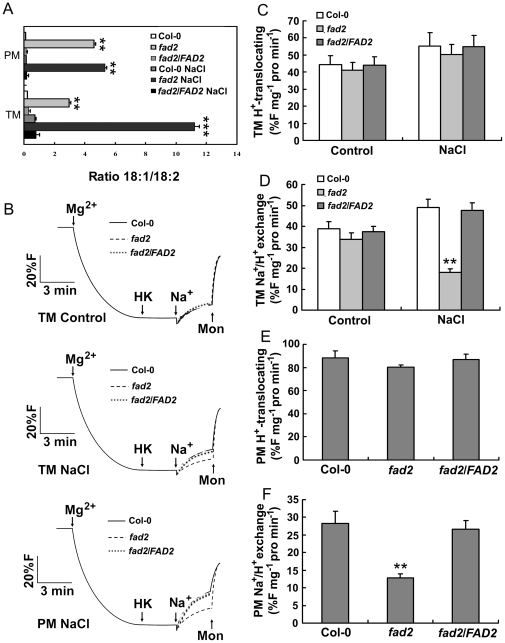
Fatty acid composition and Na+/H+ exchanger activity assays.(A) Fatty acid compositions. (B) Na+-dependent H+ exchange. TM control, tonoplast vesicles without NaCl treatment (upper); TM NaCl, tonoplast vesicles with NaCl treatment (middle); PM NaCl, plasma membrane vesicles with NaCl treatment (lower). (C) and (E) Rates of H+ translocation of tonoplast (C) and plasma membrane (E) vesicles. (D) and (F) Rates of Na+-dependent H+ effluxes in tonoplast (D) and plasma membrane (F) vesicles. Tonoplast and plasma membrane vesicles were isolated from the leaves of 4-week-old seedlings treated with or without 250 mM NaCl for 3 days. Col-0, wild-type Columbia; fad2, FAD2 mutant; fad2/FAD, fad2/FAD2-1. Results are presented as means and standard errors from four independent experiments. ** and ** indicate significant difference in comparison to wild-type at P<0.01 and P<0.001 (Student's t-test).